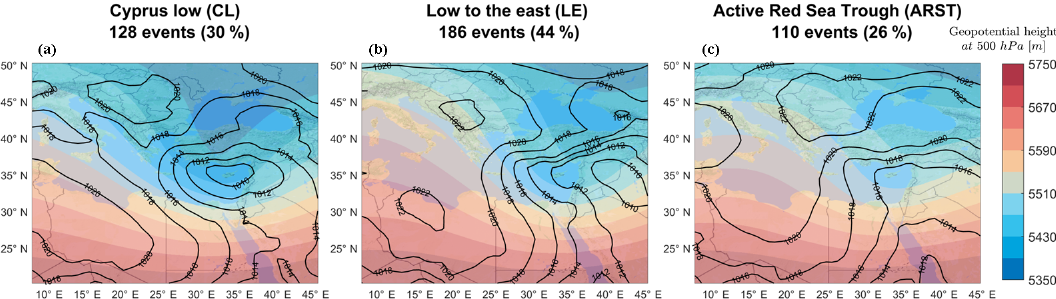
Figure 3. Average SLP (hPa, black contour lines) and geopotential height at 500hPa (m, in color) for each cluster; (a) Cyprus low, (b) low to the east, and (c) Active Red Sea Trough